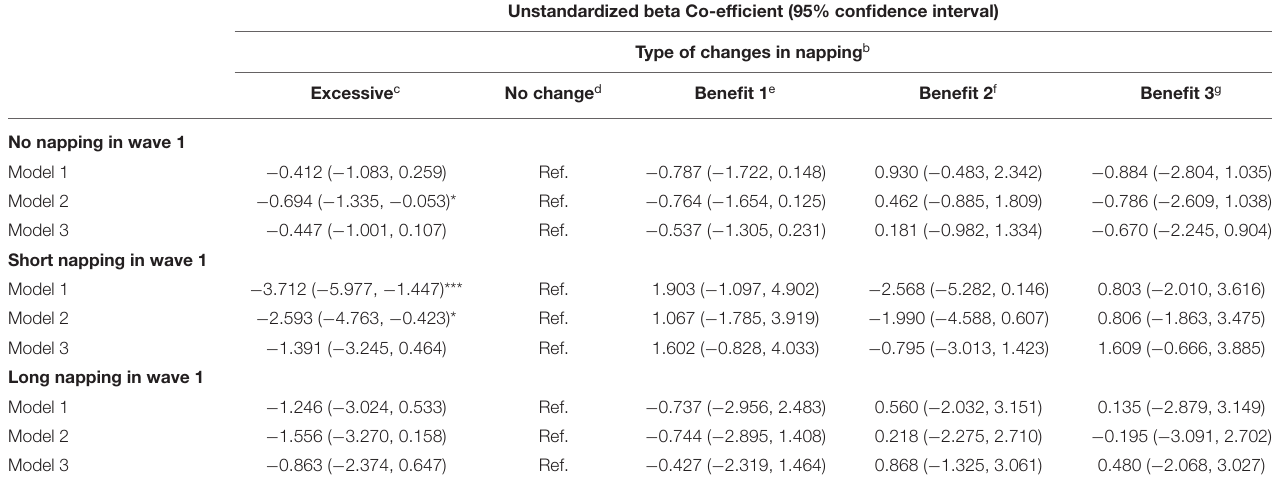
TABLE 5 | Unstandardized β Co-efficients for adjusted generalized linear models examining the relationships between variations in daytime napping and global cognition at wave 4 among participants whose napping = 0, < 30min or > 90min at baseline a . Unstandardized beta Co-efficient (95% confidence